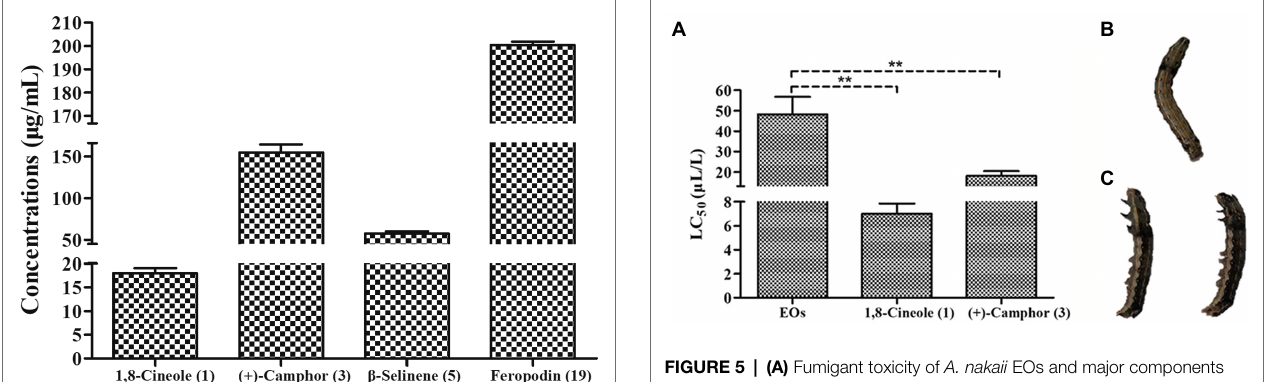
FIGURE 5 | (A) Fumigant toxicity of A. nakaii EOs and major components against Spodoptera litura. (B) Fumigant test of control group at 24 h from start of treatment (representative S. litura caterpillar). (C) Fumigant test of A. nakaii EOs under 80 μ l/L at 24 h from start of treatment (representative S. litura caterpillars). The mean differences were compared using t -tests. ** indicates that the value of p is less than